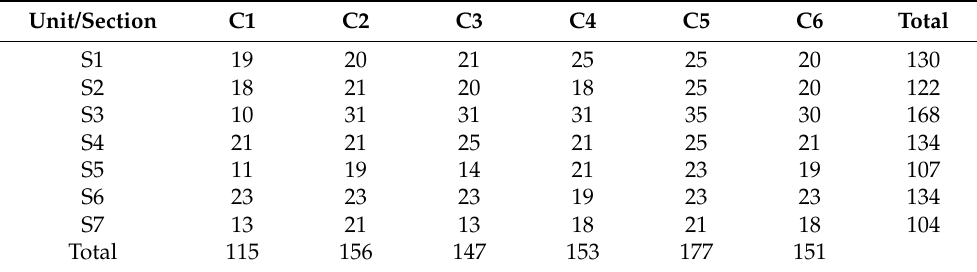
Table 7. Answers collected regarding the questions related to Hypothesis H1.